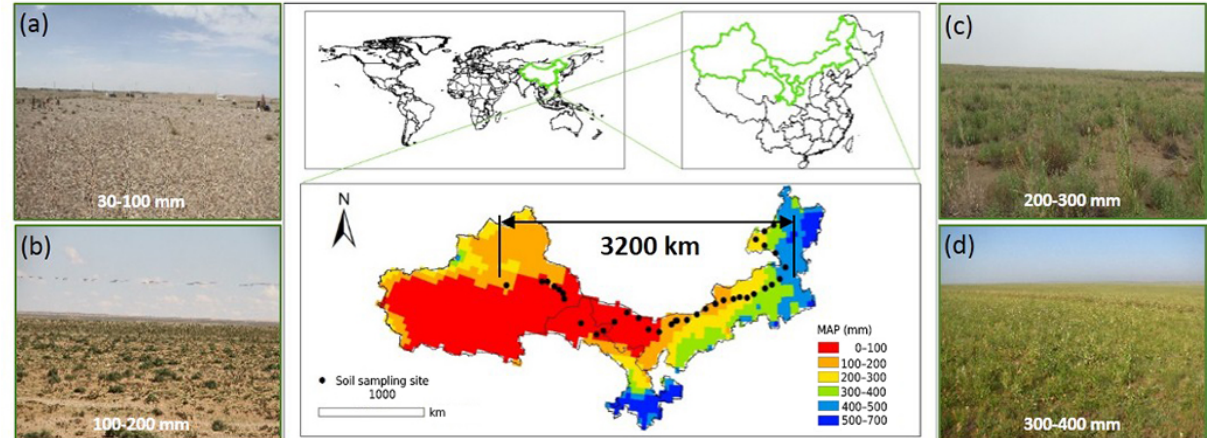
Figure 1. Vegetation type and sampling site distribution along the transect. Across the 3200km precipitation gradient in northern China, four typical vegetation types are distributed from west to east, which are desert (a) , desert steppe (b) , typical steppe (c) , and meadow steppe (d) . The dominant plant genera change gradually from shrub ( Nitraria spp., Reaumuria spp., and Salsola spp.) to perennial grasses ( Stipa spp., Leymus spp., and Cleistogenes spp.). Soil types are predominantly arid, sandy, and brown loess rich in calcium from west to east of the transect. A total of 36 soil sampling sites were